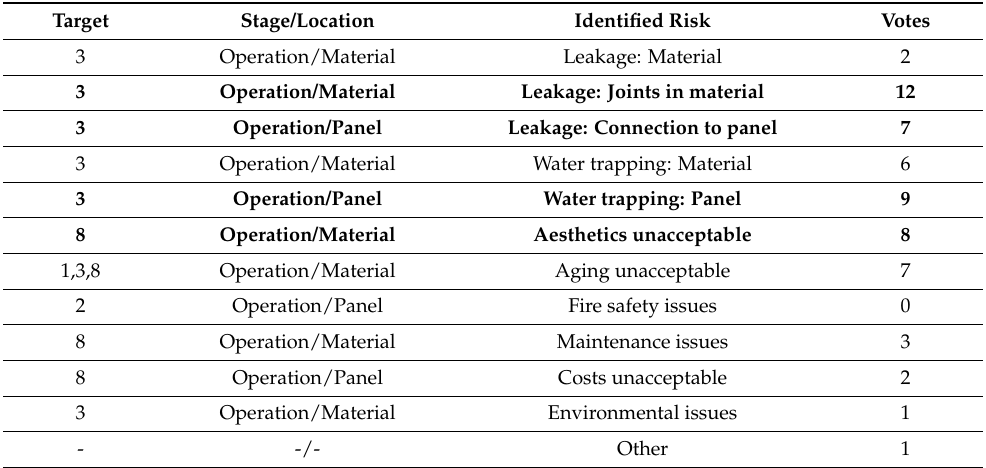
Table 4. Identified risk clusters and perceived importance to fulfilment of performance requirements. The risk clusters in bold text were selected as being of special